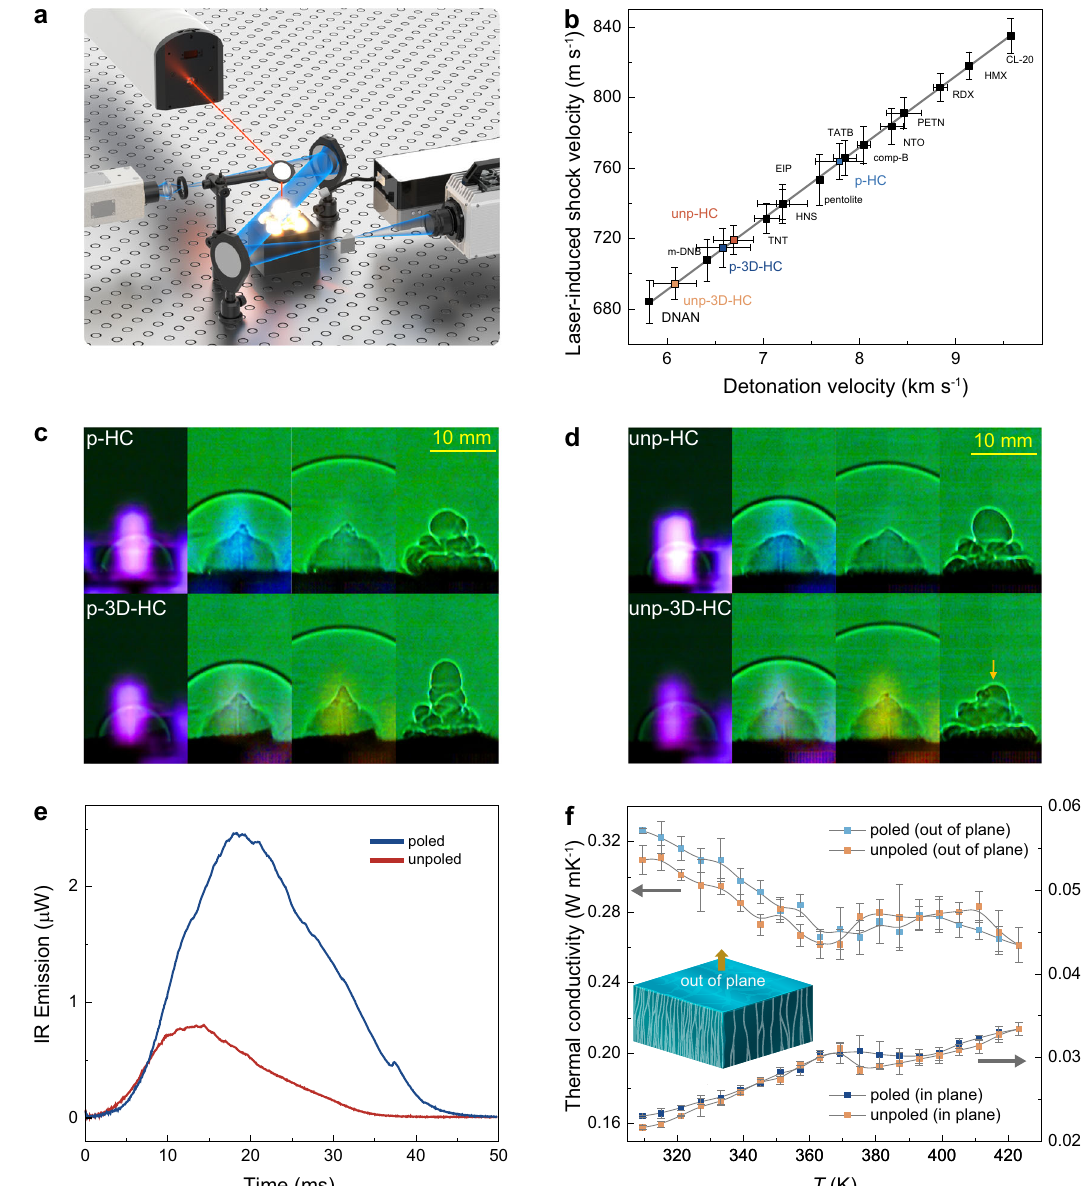
Fig.5|Ferroelectricitycontrolofchemicalenergyrelease.a Schematic fi gurefor laser-induced air shock from energetic materials study. The light from arc lamp is focusedthroughaslitontothe fi rstmirror.Thechangeintherefractiveindexofair above the sample surface is detected by collimated light between the fi rst and second mirrors. A knife edge is used to cut about half of the light rays. A spectro- meterisusedtomeasuretheplasmaemissionspectrumatthesametimeandanIR photoreceiver records the time-resolved combustion emission. b The laser- induced shock and estimated detonation velocities of poled, unpoled, 3D printed